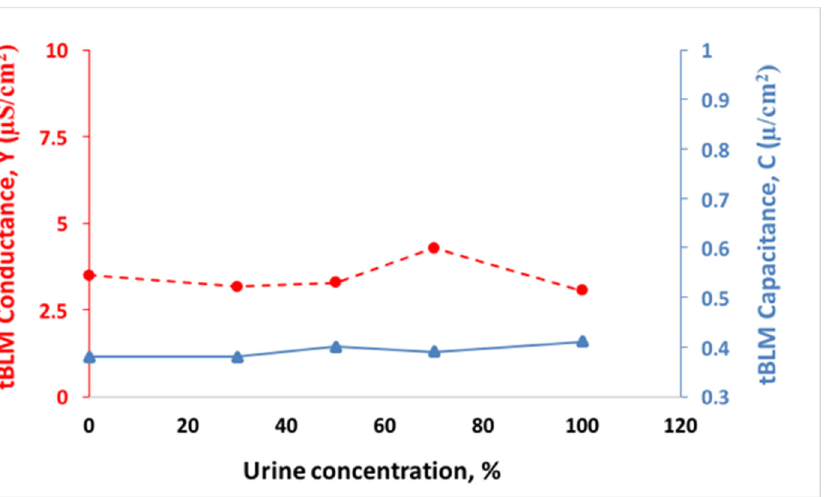
Figure 5. The effect of urine on tBLM capacitance (right axis, triangles/solid line) and conductance (left axis, circles/dashed line) composed from DOPC:CHO (in ratio % 60:40)) as a function of urine concentration. The urine impact on tBLM conductance (circles/dashed line) and on tBLM capacitance (squares/solid line) is shown.